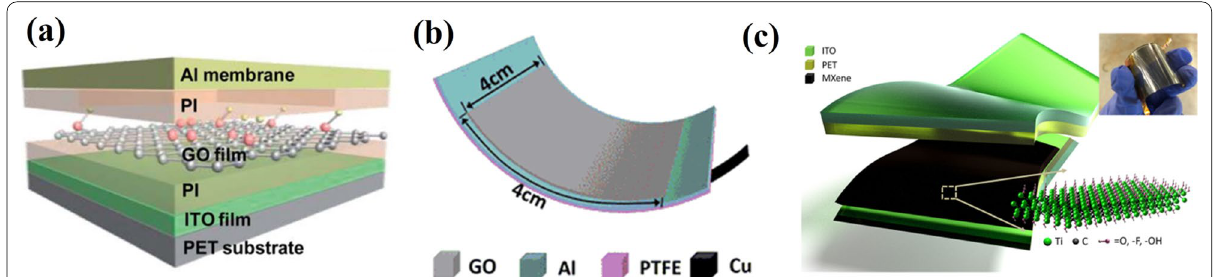
Fig. 7 Applications of 2D materials in TENG fabrication: a a multilayer structure of the Al/PI/GO/PI/ITO/PET TENG (Reproduced with permission from Ref. [57]); b a structure of the designed S-TENG (Reproduced with permission from Ref. [58]); c a structure of the MXene-based TENG (Reproduced with permission from Ref.